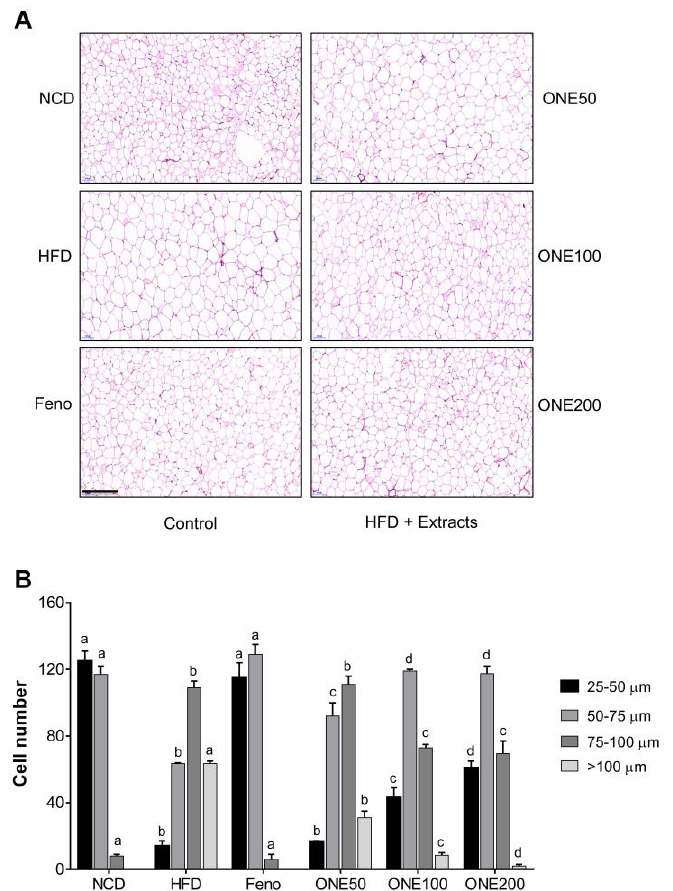
Figure 5. ONE diet reduces the size of adipocyte in white adipose tissues (WAT). ( A ) After four weeks of co-feeding with ONE, mouse WATs were collected and stained with H&E. ( B ) Number of adipocytes with various sizes (25-50, 50-75, 75-100, >100 μm) were counted. Data are presented as mean ± SEM ( n = 7). Different letters indicate statistical significance among treatment groups. Bar indicates 100 μm.